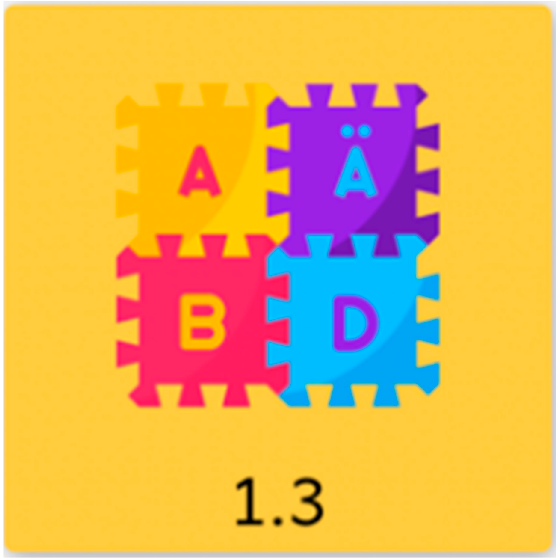
Figure 2. Image of alphabet letters reflecting Yol ŋ u letters.